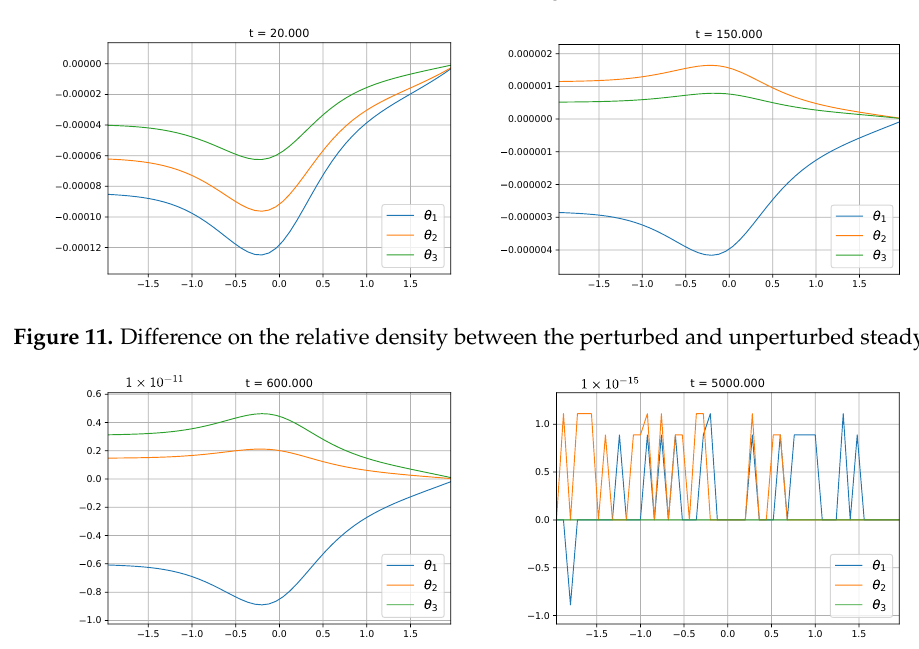
Figure 10. Initial condition for a perturbation of a well-balanced steady state with M = 3 layers. Free surface is on the left and relative densities on the right.